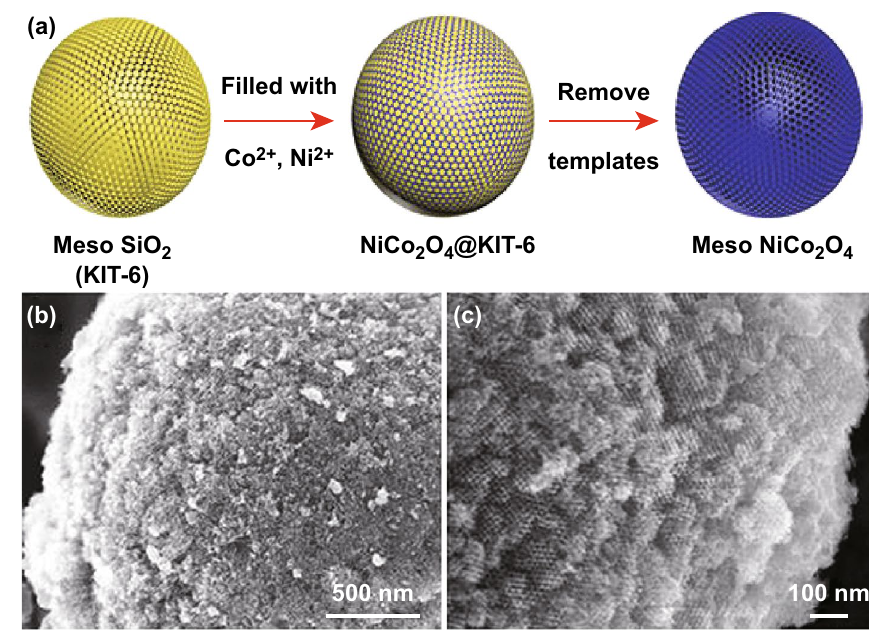
Fig. 9 a Schematic illustration of the formation of mesoporous NiCo 2 O 4 microspheres, b high-magnification FESEM image, and c TEM image of the mesoporous NiCo